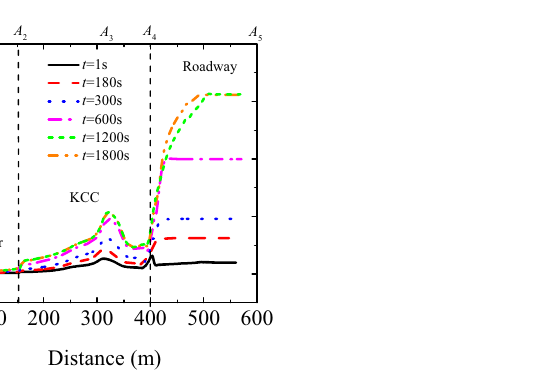
Figure 10. Curve of velocity of flow from Ordovician limestone aquifer to tunnel ( A 1 - A 2 - A 4- A 5